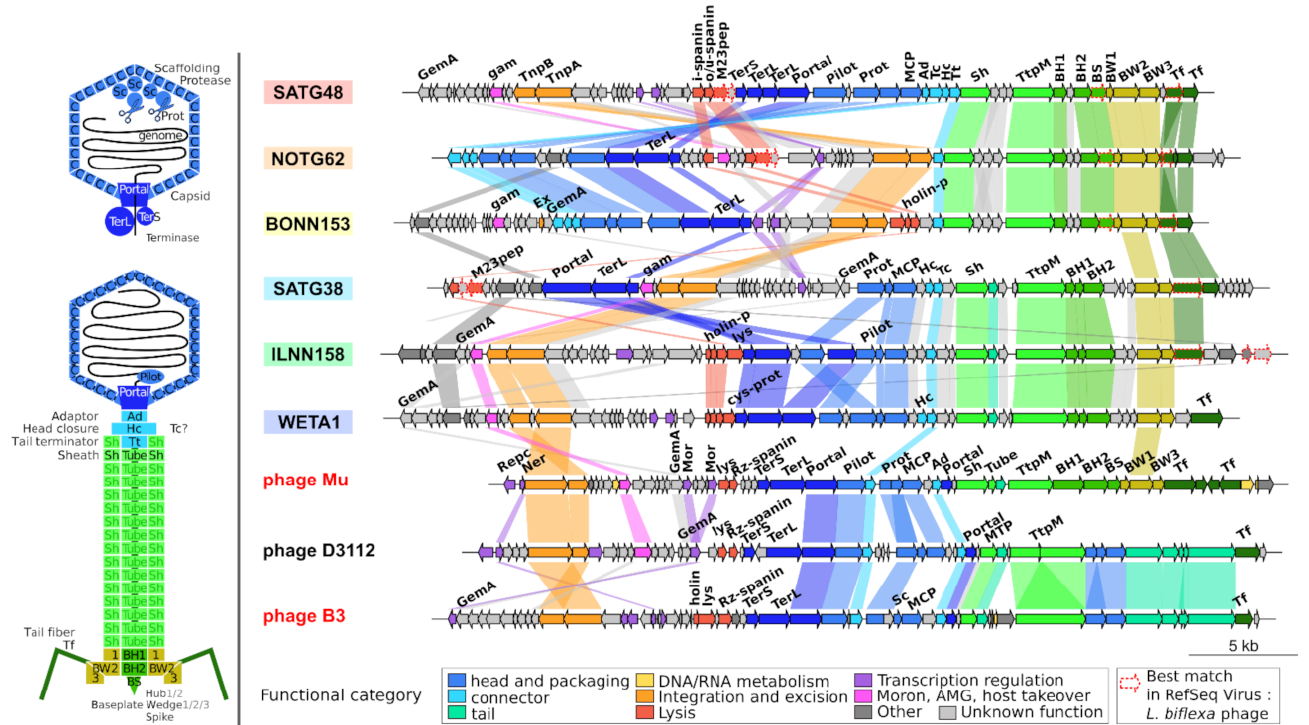
Figure 4. Genomic organization of the predicted prophages. One reference genome was chosen for each of the six prophage clades and reference phage Mu, B3, and D3112 are also shown. Protein coding genes are indicated with arrows showing their transcription orientation and are colored according to their functional category defined in the PHROG database. In addition, proteins whose best match in RefSeqVirus is a L. biflexa phage (LE1, LE3, or LE4) are highlighted in red dashed arrows. Similarities between genes from adjacent virus are displayed and were here defined by OG membership. On the left, two schematic representations of the head morphogenesis and final phage Mu structure. TnpA: transposase. TnpB: DNA transposition protein. MCP: major capsid protein; Pilot: Minor head and ejection (pilot) protein; Portal: portal protein; TerL: terminase large subunit; TerS: terminase small subunit; Sc: scaffolding; Prot: head maturation protease; BH, BS, BW: baseplate hub, spike, and wedge proteins; Sh: tail sheath; Tube: tail tube; MTP: major tail protein. TtpM: tail tape measure protein. Tf: tail fiber; SEE: semi-essential region. Ad, Hc, Tc, Tt: head-tail joining. Lys: endolysin; M23pep: metallo-peptidase; holin-p: holin/antiholin pair; and cys-prot: cysteine protease. The location of the tail completion protein (Tc, also known as neck protein Ne1) on the viral particle remains unknown. This figure summarizes Figure